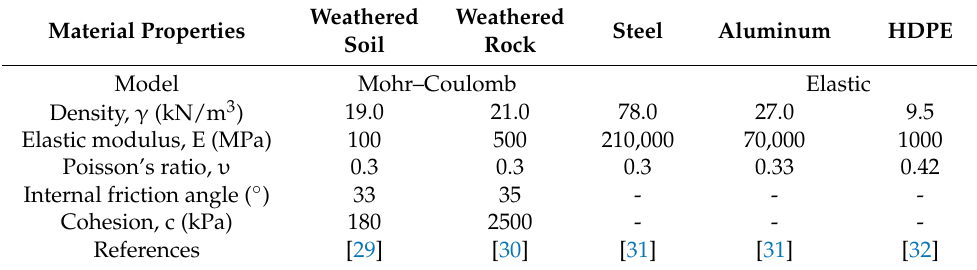
Table 1. Material properties of the ground and supporting